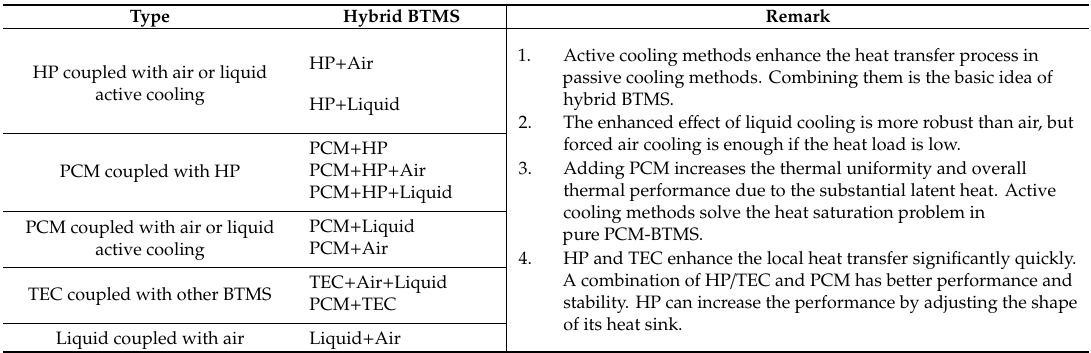
Table 1. Main types of hybrid